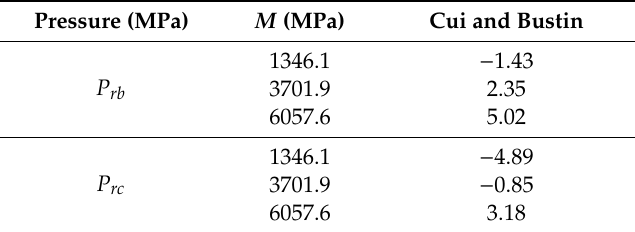
Table 8. The rebound pressure P rb and recovery pressure P rc values for the Cui and Bustin model, as obtained for the coal from the Mesaverde Group basin, Western Canada. 361